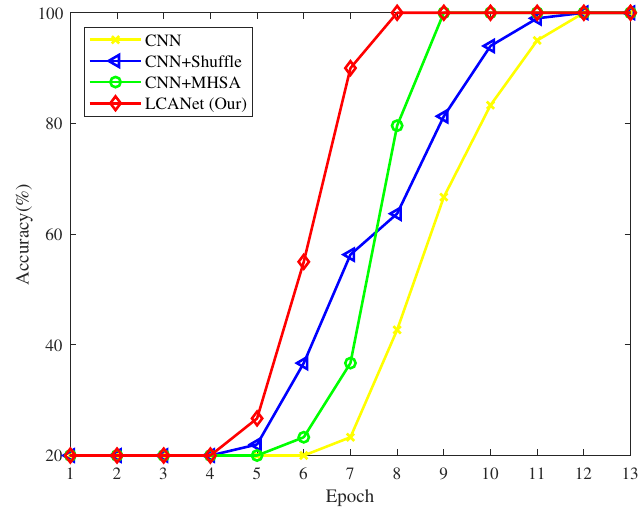
Figure 11. Ablation study of